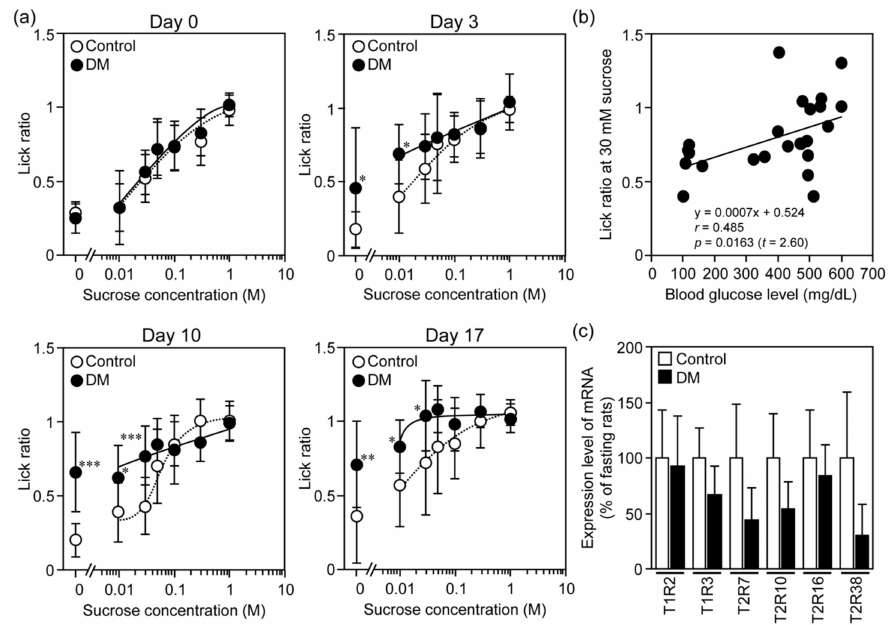
Figure 4. Alteration of the sensitivity and expression of receptors for sweet and bitter taste in STZ-induced DM rats. ( a ) Lick ratios were measured by means of a brief access test just before (day 0), and 3, 10 and 17 after i.p. administration of STZ (50 mg / kg) to them. Panel b indicates correlation between blood glucose levels and lick ratios at 30 mM sucrose on Days 0, 3, 10 and 17 in rats. ( c ) The expression levels of mRNAs for sweet (T1R2 and T1R3) and bitter (T2R7, T2R10, T2R16 and T2R38) taste receptors in CP isolated from their tongues on day 35 were determined by real-time PCR. mRNA expression levels of taste receptors were normalized against the corresponding levels of β -actin mRNA. Each point / bar represents the mean ± SD for 10 (control) and 6 (STZ) rats. * p < 0.05, ** p < 0.01, *** p < 0.001 (vs.